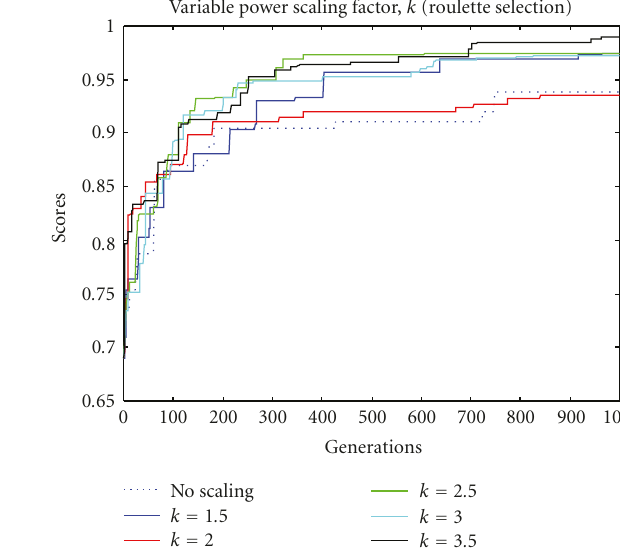
Figure 8: Fitness with linear scaling. Figure 9: Fitness with power law scaling.